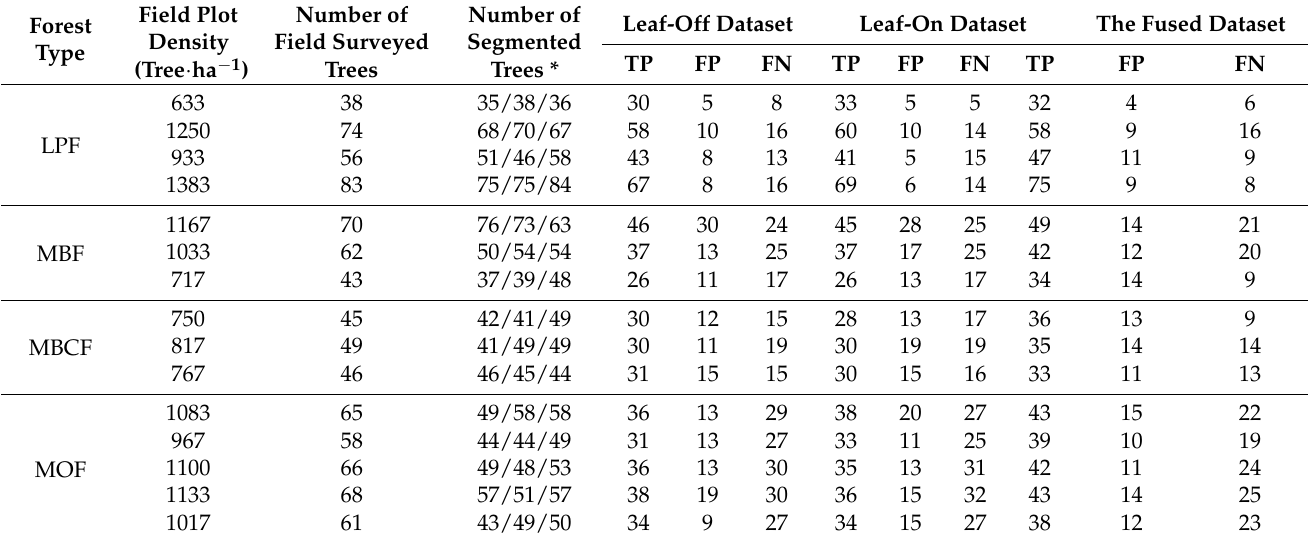
Table 4. Performance of tree segmentations by LLS algorithm on the filed plots.